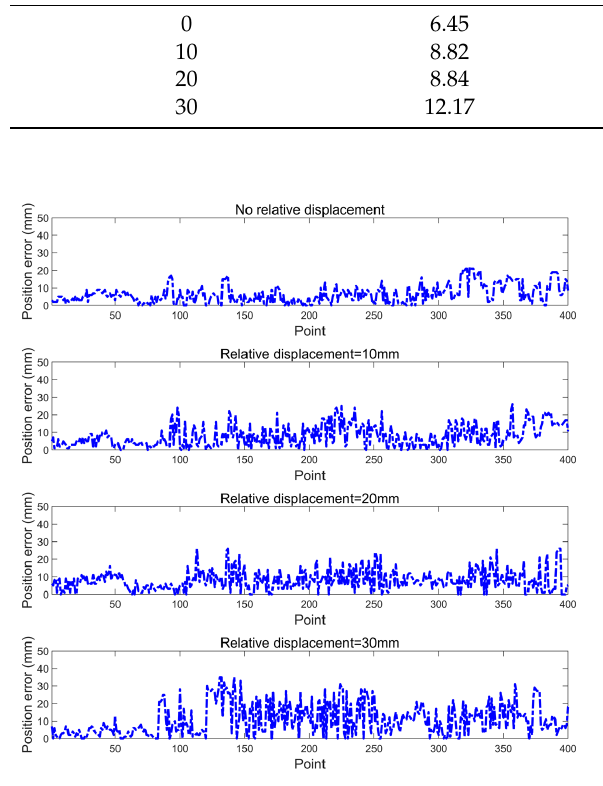
Figure 12. Localization error of the navigation reflectors with relative displacement. Table 7. Localization error of the navigation reflectors with relative displacement.